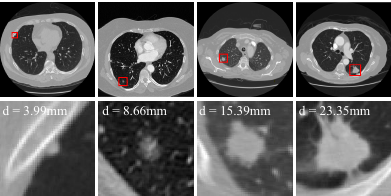
Figure 1. Examples of the nodules in the LUNA16 dataset. The first row shows the nodules (red boxes) from four raw LDCT scans. Meanwhile, each nodule is zoomed in and shown in the second row.